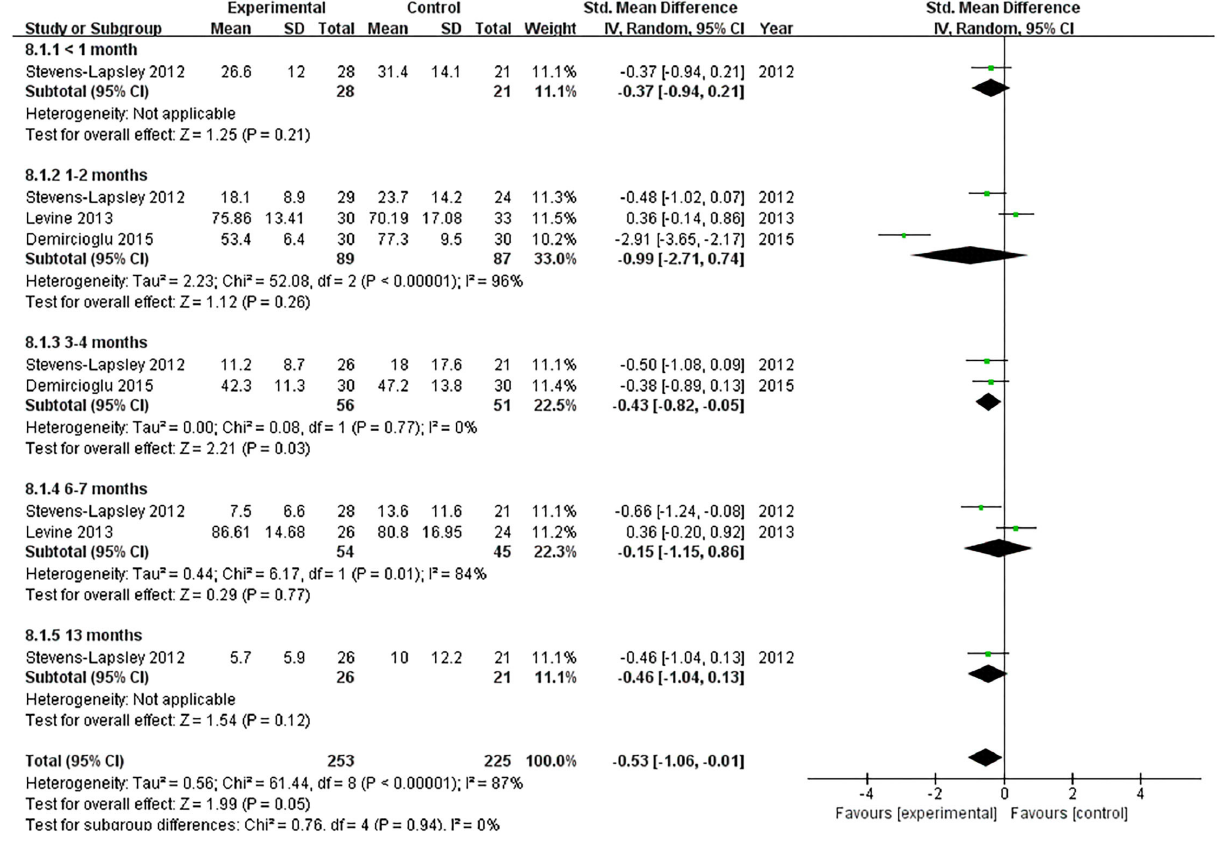
FIGURE 7 | Forest plots of meta-analysis of the effect of NMES vs. conventional rehabilitation on the Western Ontario and McMaster Universities Osteoarthritis